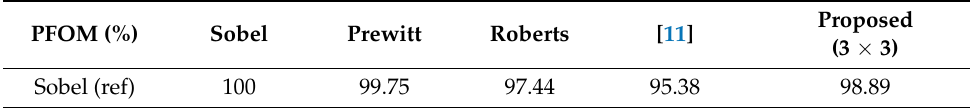
Figure 5. ( a ) Original image and images obtained using the existing mask algorithms: ( b ) the Sobel mask, ( c ) the Prewitt mask, ( d ) the Roberts mask, ( e ) the column-comparing mask [11], and ( f ) the mask built into column circuits. Table 1. Pratt’s figure of merit (PFOM) of the different masks.